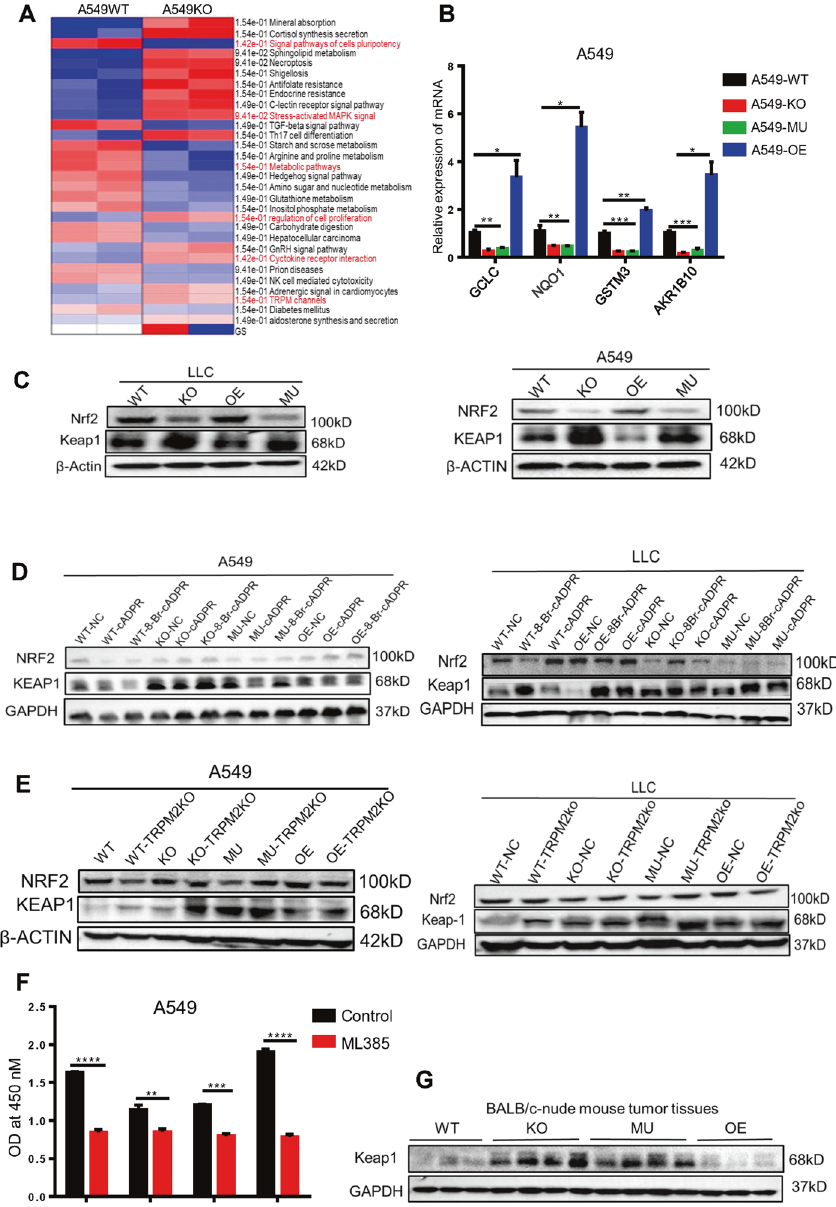
Fig. 6 cADPR regulated KEAP1/NRF2 signal pathway to facilitate tumor progression. A Heat map showed the signi fi cant differences of signaling pathways from A549 CD38 WT and CD38 KO tumor cells by Kyoto Encyclopedia of Genes and Genomes (KEGG) analysis. B Relative mRNA expression levels of GCLC, NQO1, GSTM3, and ARK1B10 were shown in A549 cells calculated by qRT-PCR. And GAPDH was used as internal control ( n = 3). C Western blotting was con fi rmed the expression of KEAP1 and NRF2 in A549 and LLC cells. GAPDH was shown as control. D Western blotting was used to detect the expression of KEAP1 and NRF2 in A549 and LLC cells treated with control, cADPR (for LLC was 50 nM, for A549 was 100 nM, 24 h) and 8-Br-cADPR (for LLC was 10 μ M, for A549 was 20 μ M, 24 h). E Western blotting was used to analysis of the expression of KEAP1 and NRF2 in A549 and LLC cells treated with an empty control PX458-plasmid (TRPM2-NC) or PX458-sgTRPM2- plasmid (sgTRPM2, TRPM2 KO). F A549 cells were seeded at a density of 3000 cells/well into 96-well plates treated with ML385 (10 μ M) for 48 h and then cell viability was detected by using a CCK-8 assay, and the results were expressed as the OD value ( n = 3). G Western blotting was used to analysis of the expression of Keap1 from LLC bearing-BALB/c-nude tumor tissues. Data were presented as mean ± SEM. ANOVA or test was used to analyze data. ns, no signi fi cant difference; * P < 0.05; ** P < 0.01; *** P < 0.001, **** P <